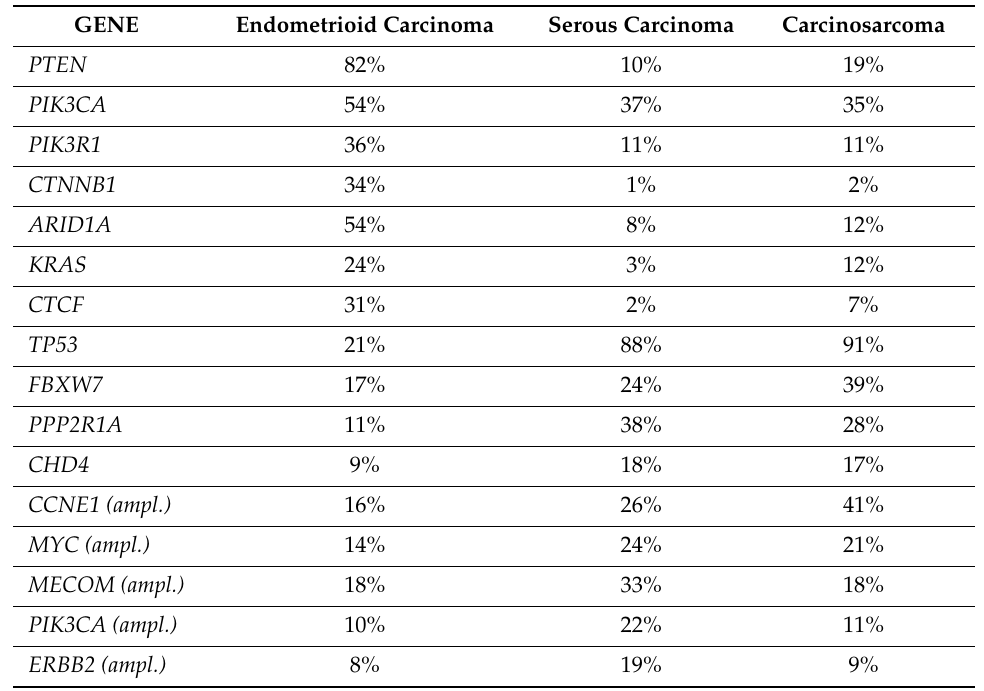
Table 1. Comparison of gene mutation frequency among di ff erent histological types of endometrial cancer according to The Cancer Genome Atlas Program (TCGA). GENE Endometrioid Carcinoma Serous